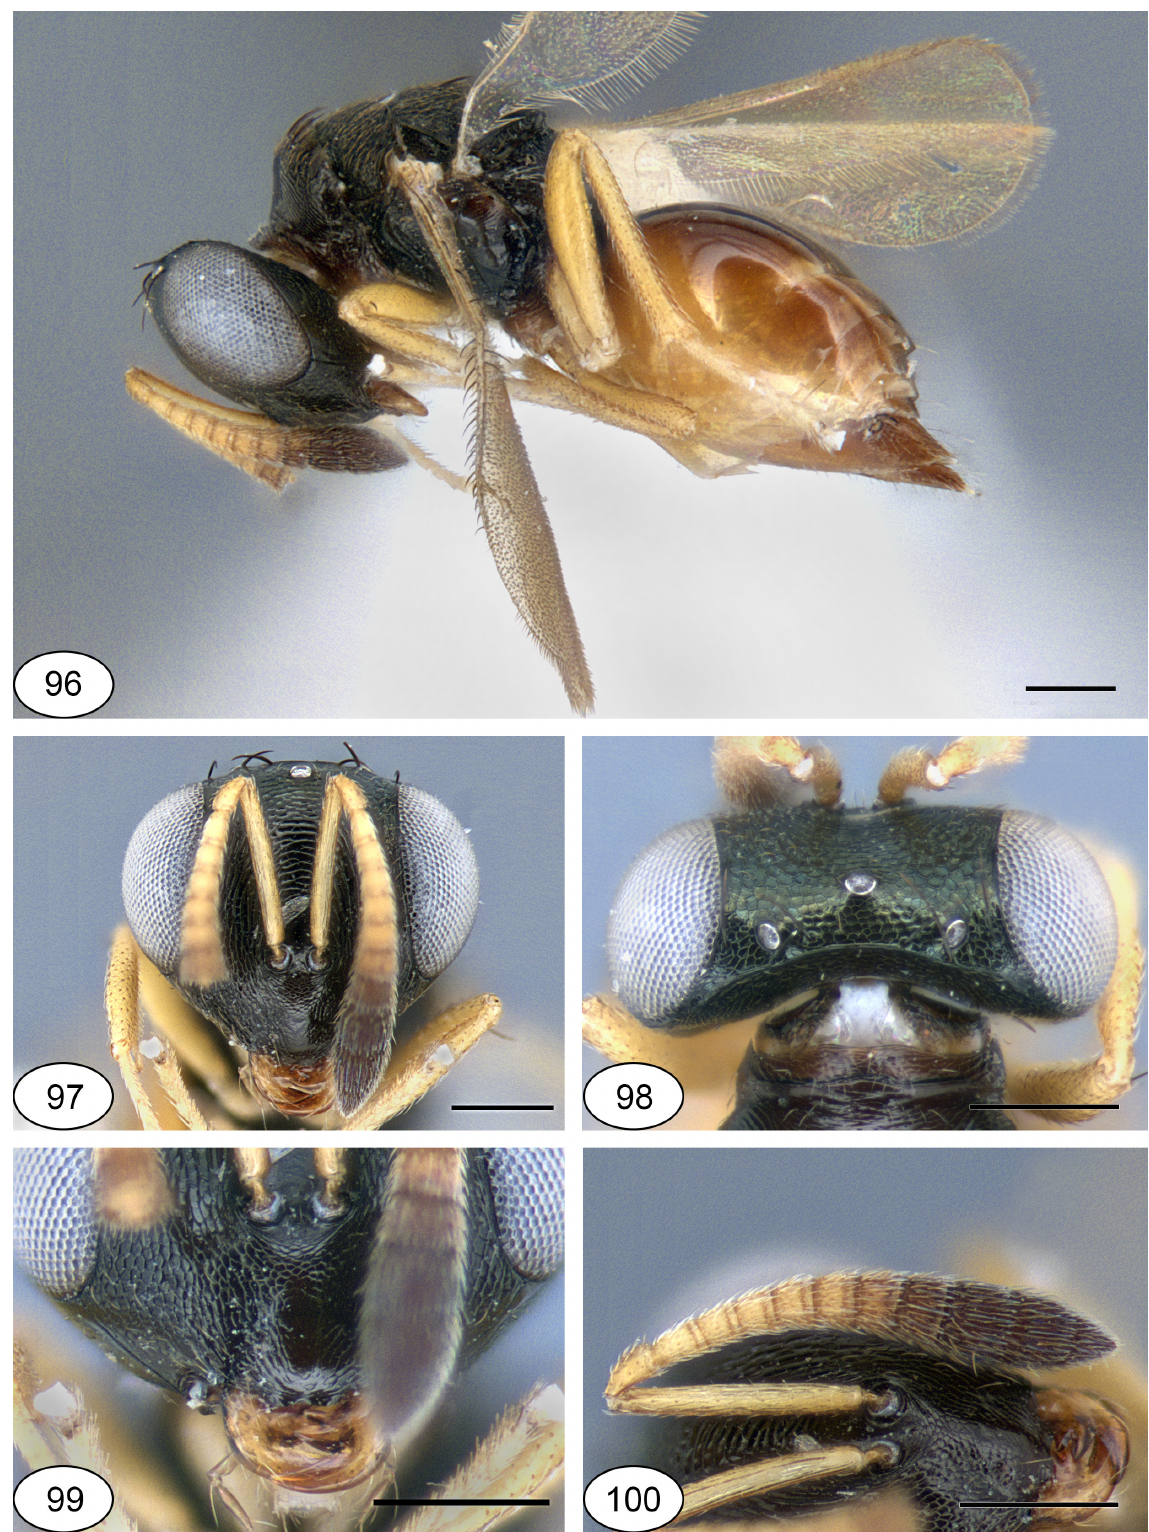
Figs 96–100. Netomocera masneri sp. nov., holotype, ♀. 96 . Habitus, lateral view. 97 . Head, frontal view. 98 . Head, dorsal view. 99 . Lower face. 100 . Antenna. Scale bars: 0.2